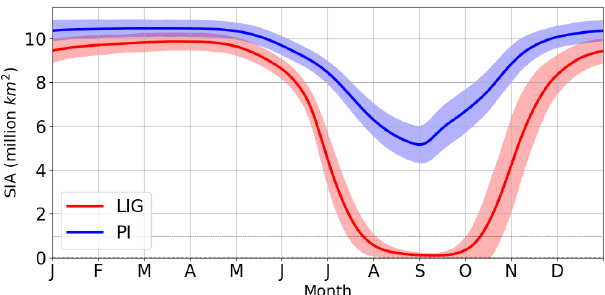
Figure 1. Annual cycle of Arctic sea-ice area (SIA). The 200-year mean calculated from daily model output from 70–90 ◦ N for the LIG (red) and PI (blue) simulations is